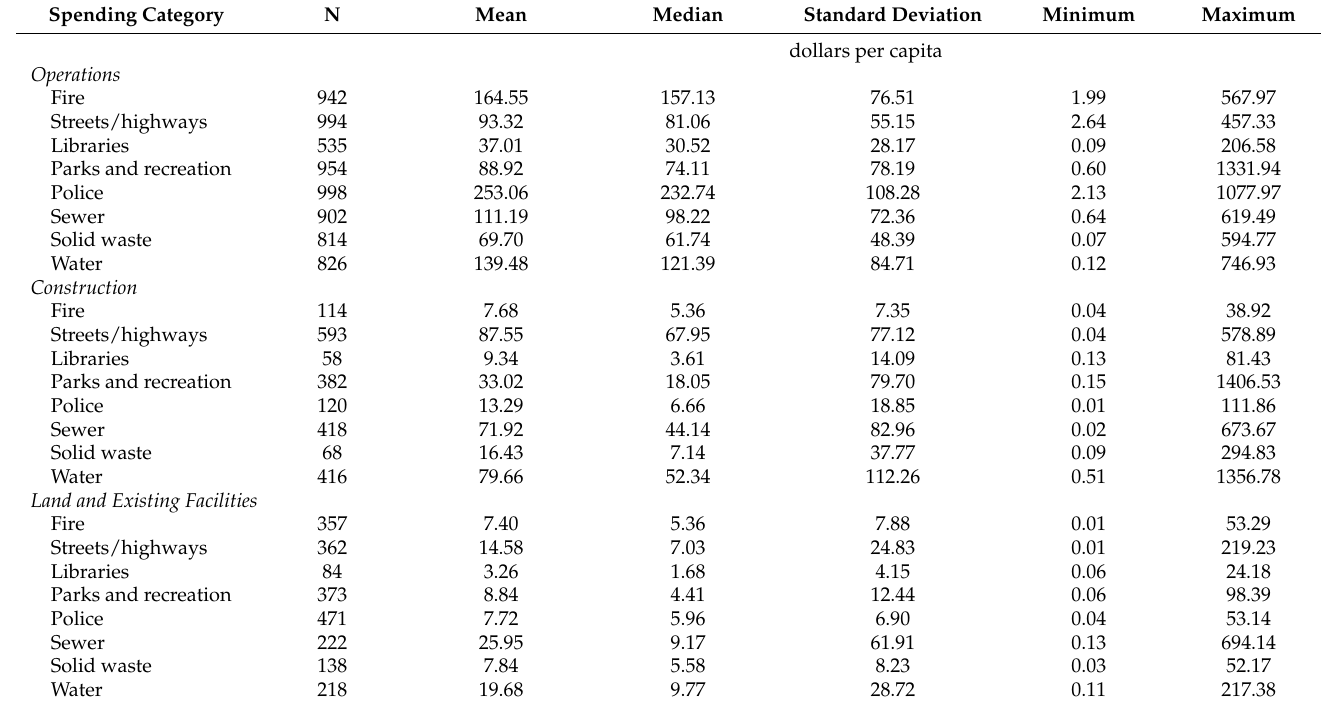
Table 1. Per capita municipal spending data, cities with population greater than 25,000.